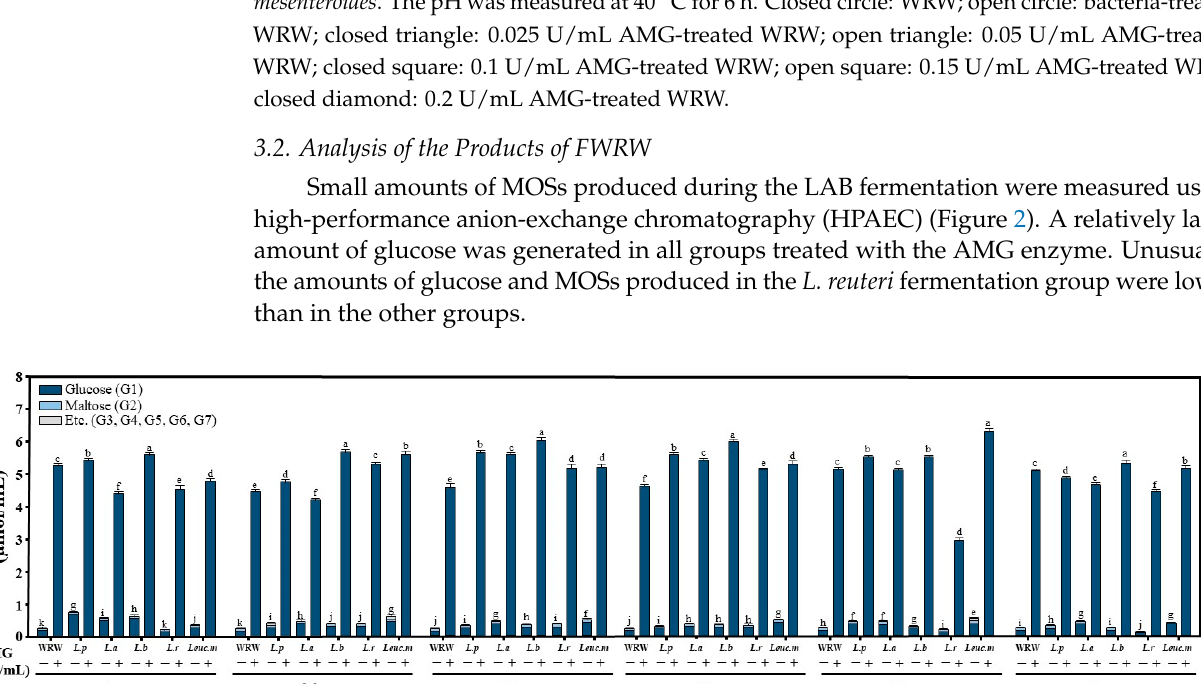
Figure 1. Changes in pH of FWRW with various AMG concentrations. Rice water was fermented using the following five types of LAB based on previous experiments: ( A ) Lactobacillus reuteri, ( B ) Lactobacillus acidophilus, ( C ) Lactobacillus brevis , ( D ) Lactobacillus plantarum , and ( E ) Leuconostoc mesenteroides . The pH was measured at 40 ◦ C for 6 h. Closed circle: WRW; open circle: bacteria-treated WRW; closed triangle: 0.025 U/mL AMG-treated WRW; open triangle: 0.05 U/mL AMG-treated WRW; closed square: 0.1 U/mL AMG-treated WRW; open square: 0.15 U/mL AMG-treated WRW; closed diamond: 0.2 U/mL AMG-treated WRW.